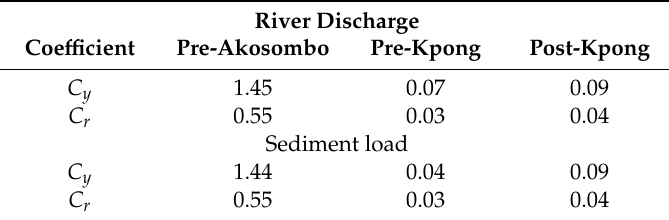
Table 2. The nonuniformity coe ffi cient ( C y ) and regulated coe ffi cient ( C r ) for the river discharge and sediment load for the periods of pre-Akosombo Dam, pre-Kpong Dam, and post-Kpong Dam.